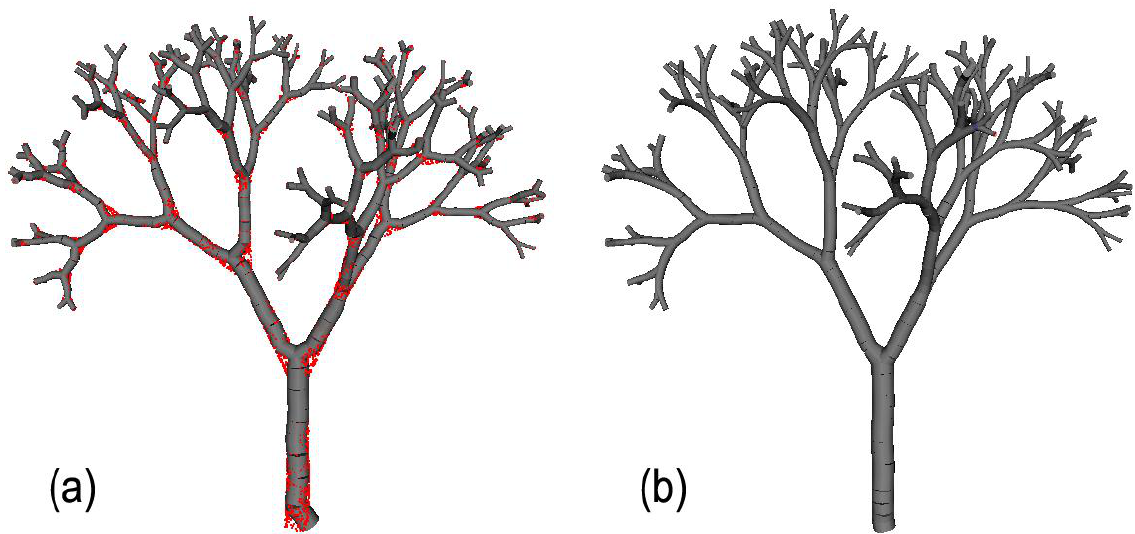
Figure 6. ( a ) Non-optimal reconstruction of the synthetic model (126 tips detected among the 128); ( b ) Perfect semi-supervised reconstruction (128 tips), using smoothing ( w = 3) and the use branch creation